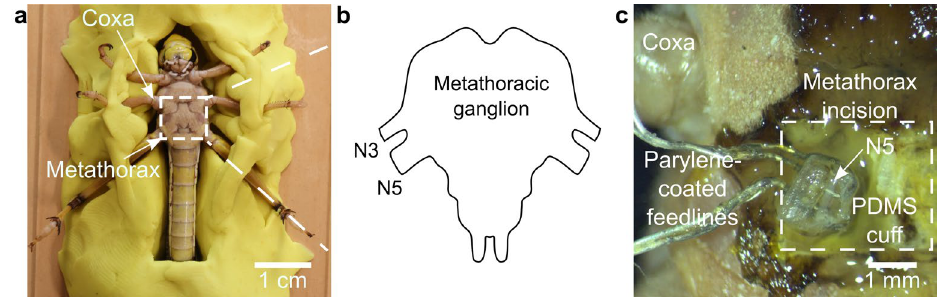
Figure 3. ( a ) Locusta migratoria prior to the surgery in clay bed. ( b ) Scheme of the metathoracic ganglion and the nerves innervating the hind leg. ( c ) Microscope image of the surgical incision on the metathorax of the locust, showcasing the N5 immediately before insertion in the cuff electrode.